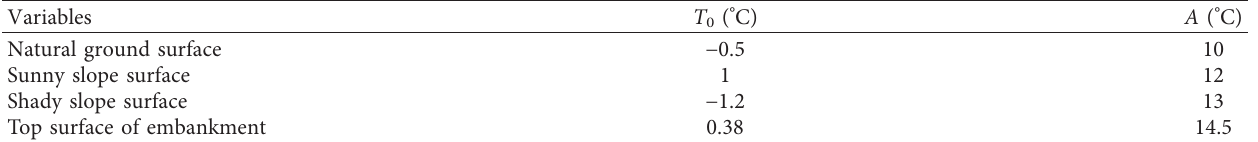
Table 2: Temperature parameters of upper boundary